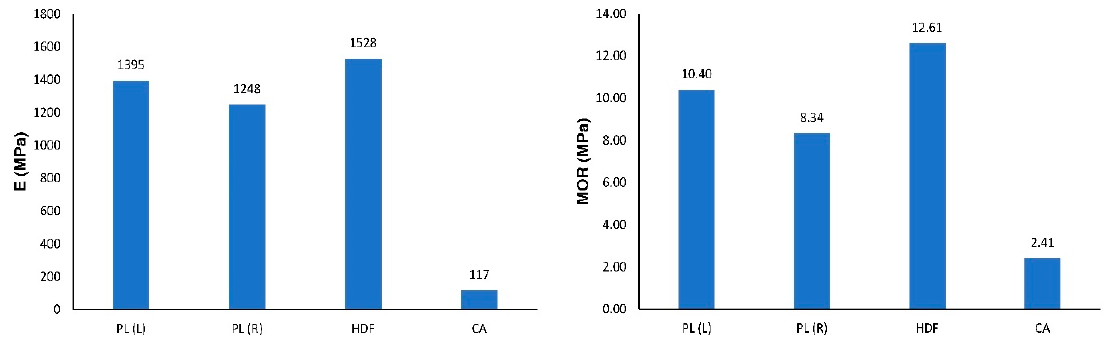
Figure 7. A comparison of E and MOR for selected wood-based composites.